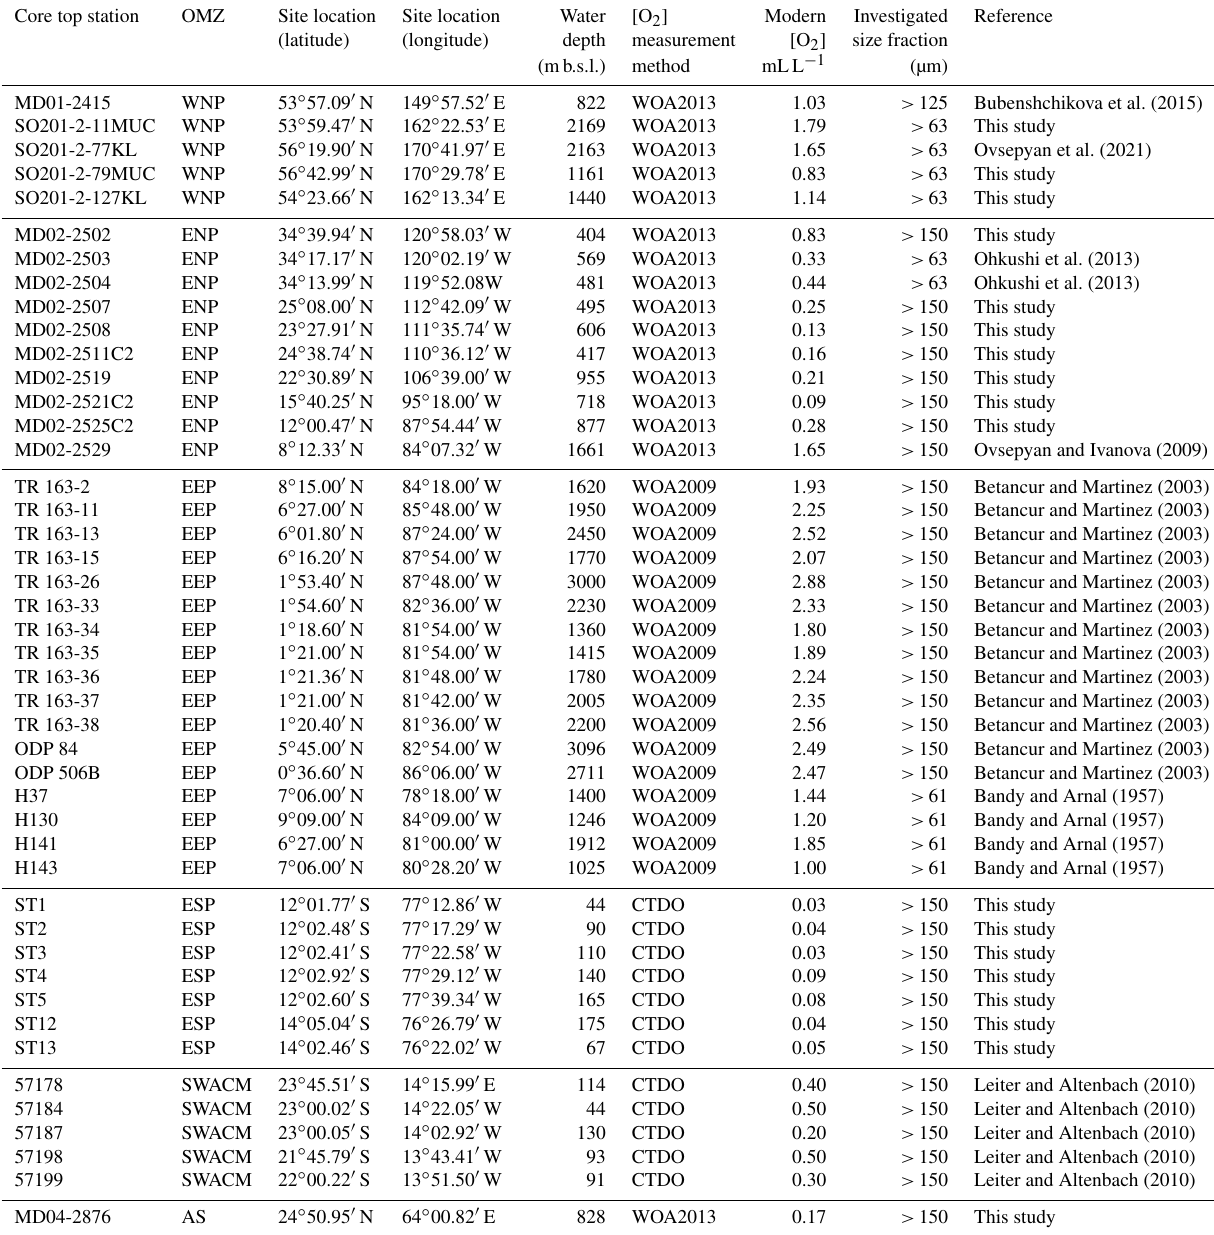
Table 1. Core station location and depth and modern dissolved oxygen level for each investigated core top sample. WOA2013 and WOA2009 refer to the World Ocean Atlas 2013 and World Ocean Atlas 2009 ,